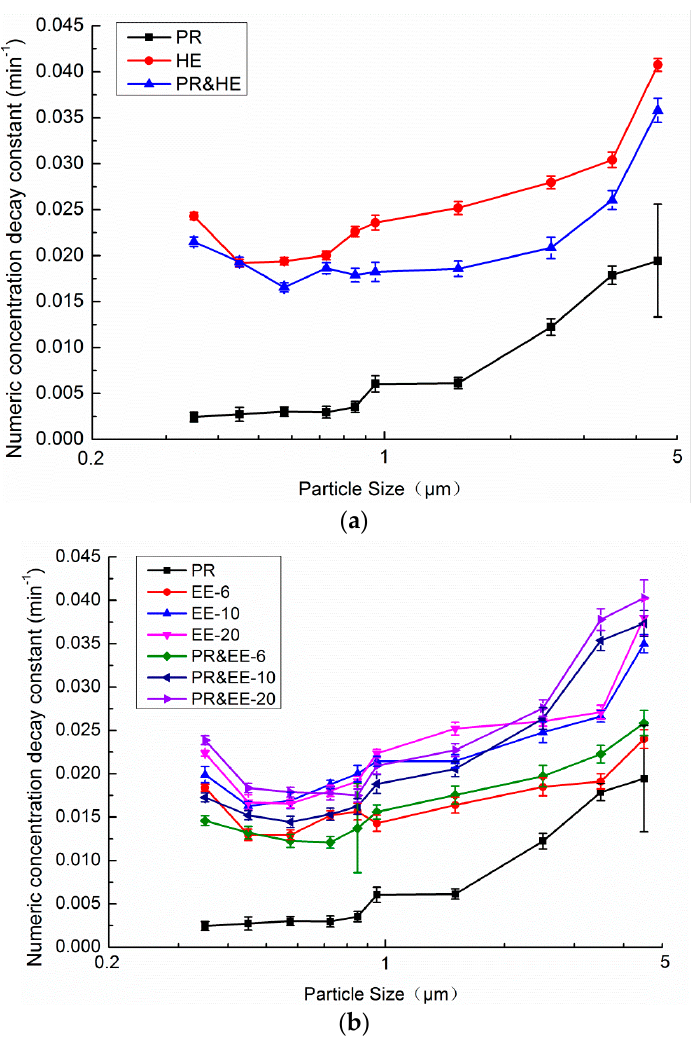
Figure 13. Size-resolved numeric concentration decay constant over 1 h for single filter PACs with and without PR filter. ( a ) High efficiency filter; ( b ) Electret filters.